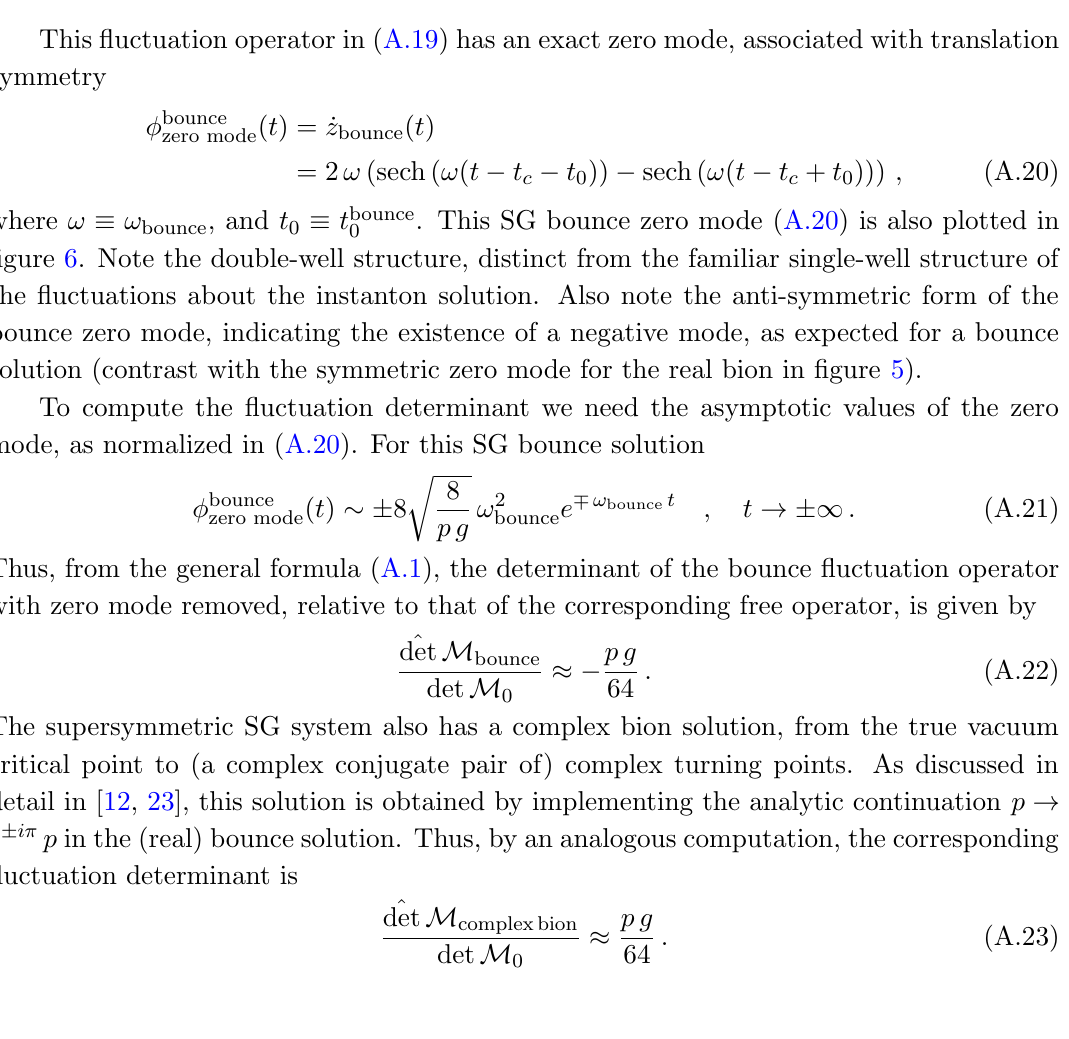
Figure 6 . Plot of the (cid:13)uctuation potential in (A.19) for the SG bounce solution (solid blue curve), together with the zero mode (dashed red curve) in (A.20). Note the double-well structure of the (cid:13)uctuation potential, and the anti-symmetric nature of the zero mode solution, characteristic of a bounce solution, leading to a negative (cid:13)uctuation